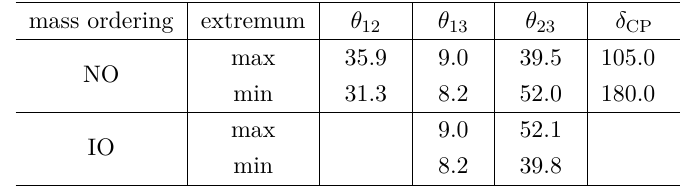
Table 5 . For the normal (NO) and inverse (IO) order of neutrino masses, the values of oscillation angles and phase needed to maximize or minimize the branching ratio R h